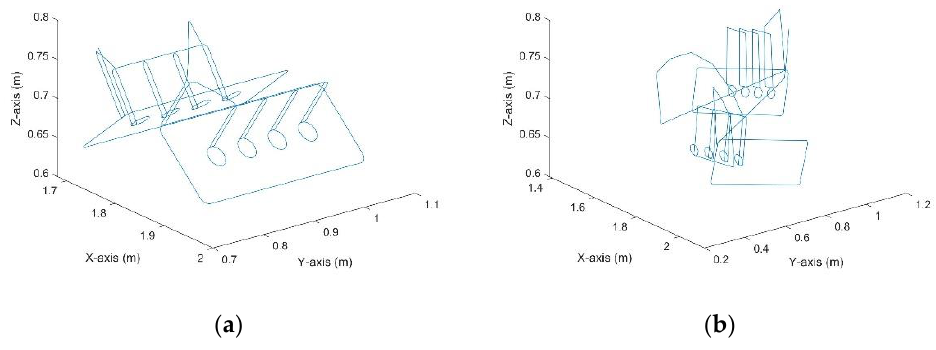
Figure 9. The original ( a ) and the optimized ( b ) deburring toolpath.